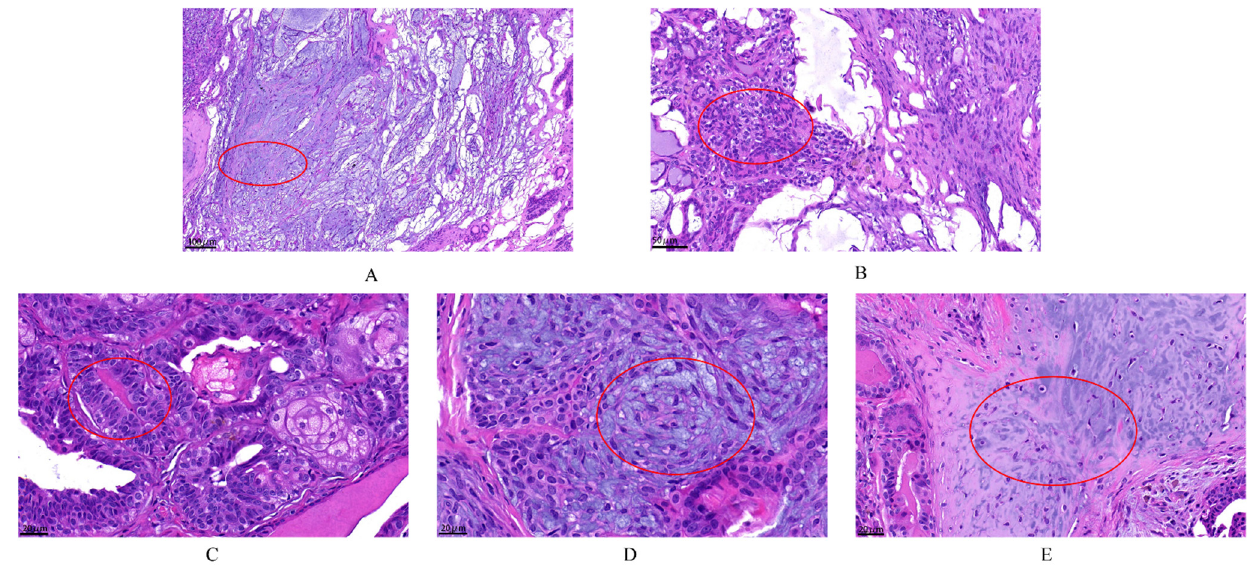
Figure 2. The histopathological examination of canine mammary tumors. The dye was Hematoxylin and Eosin (H&E) (G1120, Solarbio). ( A , B ) complex adenoma: There is pleomorphism of the epithelial cells that line the tubules but not the fusiform myoepithelial cells. Complex adenoma has both epithelial (tubular) and myoepithelial proliferation. This neoplasm consists of two cell populations and variable amounts of fibrous stroma. The cells are cuboidal to columnar and have a moderate amount of eosinophilic cytoplasm. Nuclei are round to oval with finely stippled or marginated chromatin and a single central basophilic nucleolus. Anisokaryosis and anisocytosis are usually minimal. The second population is composed of spindle to stellate cells with poorly demarcated cell borders and a moderate amount of cytoplasm. Nuclei are round to fusiform with finely stippled chromatin and a single nucleolus. ( C – E ) carcinoma arising in benign mixed tumor grade I: The malignant epithelial component forms tubules, and the mesenchymal component consists of islands of bone. The first population is composed of cuboidal cells arranged in irregular tubules (see ( C ) tumors break down during the growth). The cells have clear but irregular nucleoli and increased mitosis. The nucleolus is irregular. The second population is composed of spindle-shaped cells (myoepithelial cells; see ( D )). These cells have a moderate amount of basophilic cytoplasm with poorly demarcated cell borders. The third component consists of foci of cartilage tissue, which exhibit no atypia (see ( E )). There is an infiltrative growth